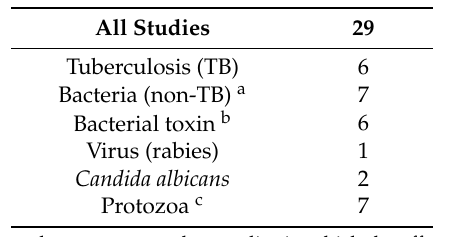
Table 3. Infectious agents in studies in which vitamin C decreased the mortality of mammals by p ≤